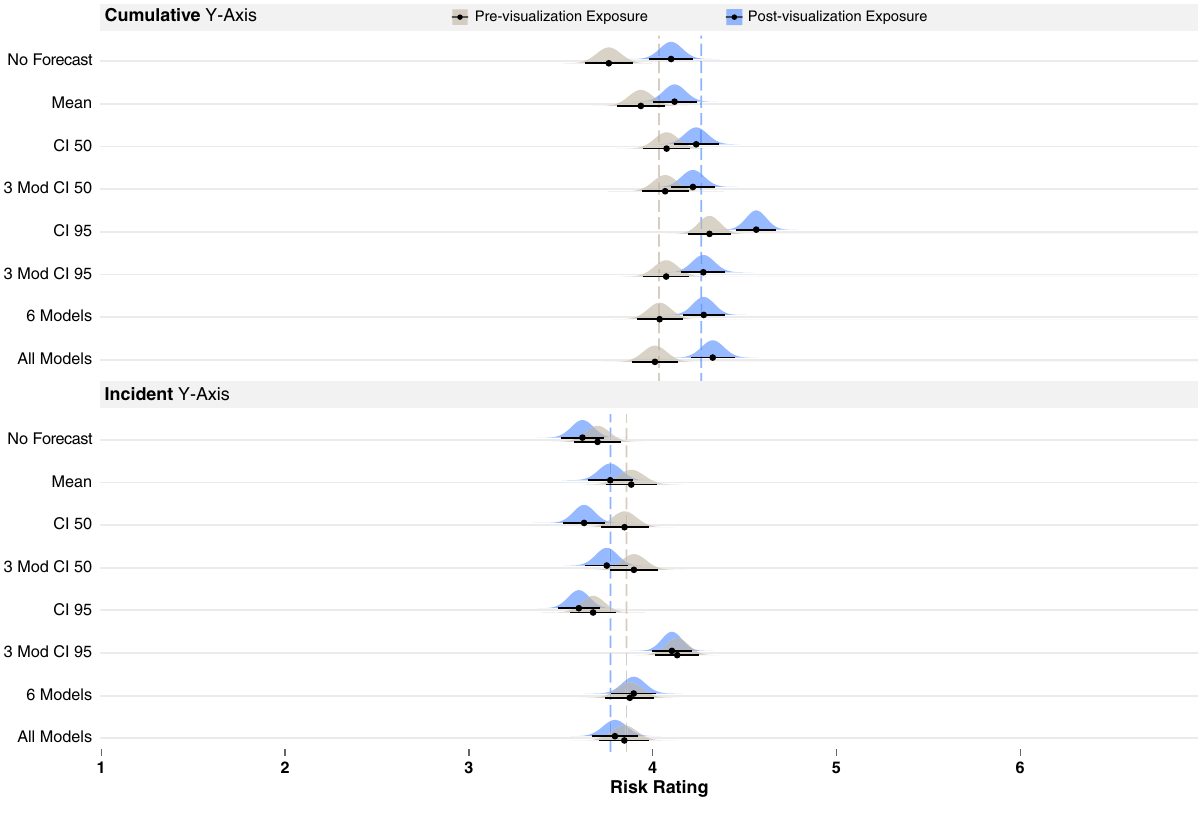
Figure 2. Results of Experiment 1, where pre-visualization risk judgments are colored gray and post- visualization judgments blue, for cumulative y-axis (top) and incident y-axis (bottom). Dashed lines show the mean pre- and post-visualization risk judgments for each y-axis group as a whole. Black bars show 95% confidence intervals around the mean (black dot) for each condition using the Cousineau–Morey method 44 and the density plots were generated from this